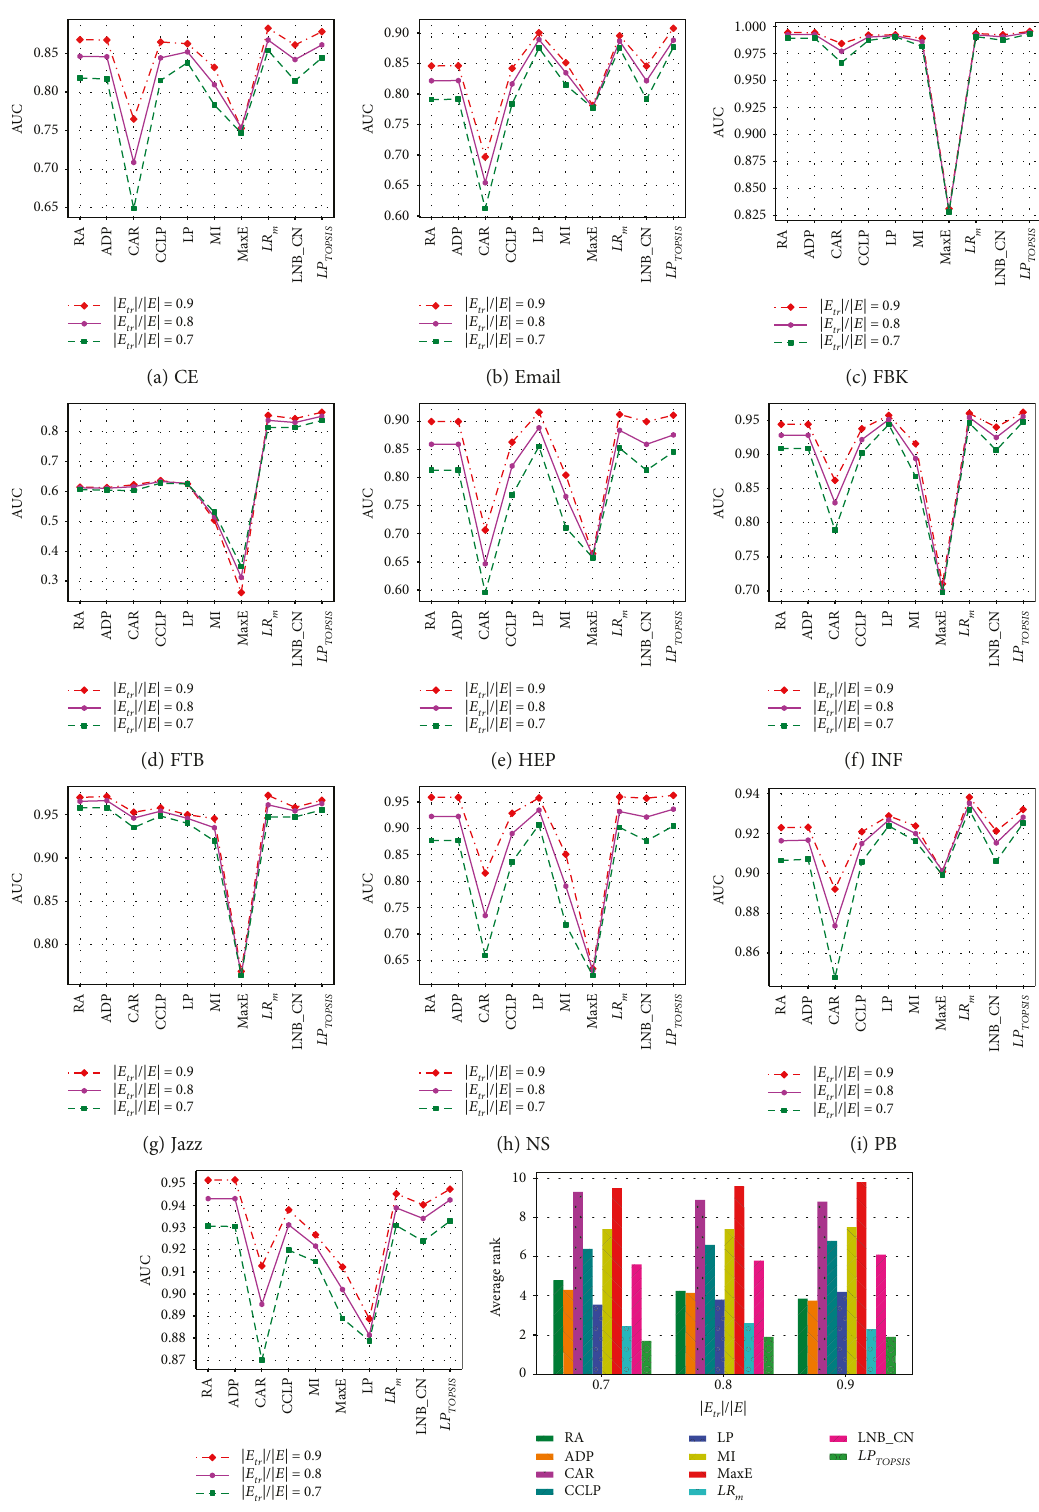
Figure 5: AUC results on 10 networks with di ff erent proportions of training set E